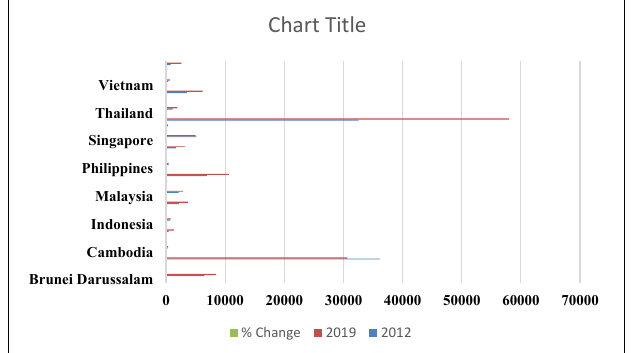
FIGURE 1 | % age Changes in the Association of Southeast Asian Nations selected variables between 2012 and